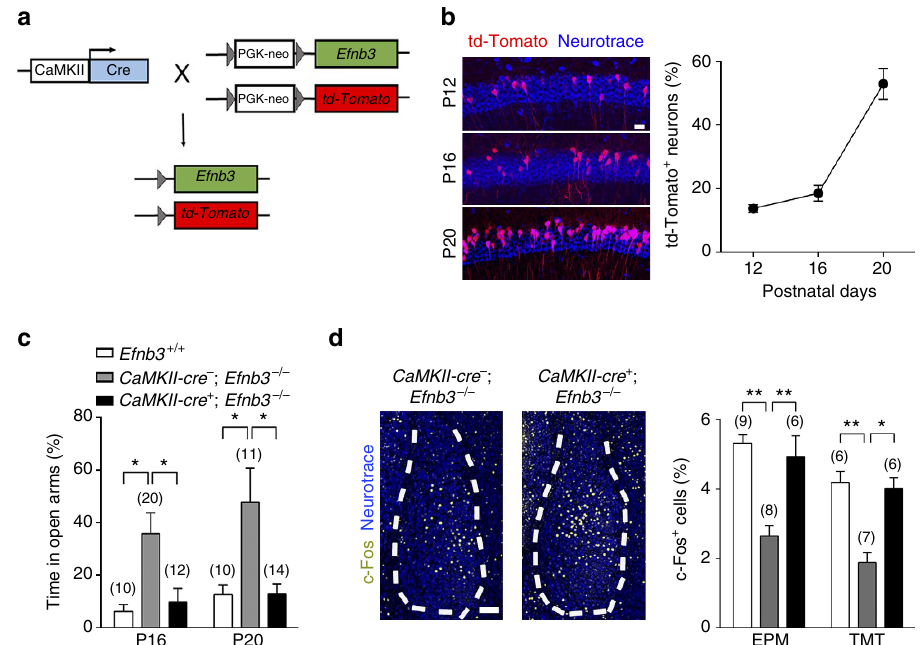
Figure 3 | Spatial-specific rescue of eB3 restores defensive responses in Efnb3 (cid:2) / (cid:2) mutant. ( a ) Transgenic mice expressing CaMKII-Cre recombinase were crossed with td-Tomato þ ; Efnb3 (cid:2) / (cid:2) homozygotes. EB3 expression in the initial td-Tomato þ ; Efnb3 (cid:2) / (cid:2) mutant was restored and indicated with td-Tomato reporter on Cre -mediated excision of the loxP -flanked PGK neo cassette. ( b ) CaMKII-cre mediated recombination in CA1 area visualized with td-Tomato fluorescence was detected in P12, P16 and P20 hippocampal sections in CaMKII-cre þ ; td-Tomato þ ; Efnb3 (cid:2) / (cid:2) mice. Scale bar, 50 m m. The percentage of td-Tomato-positive cells in CA1 area increased gradually during postnatal development. n ¼ 3 mice for per group. ( c ) CaMKII - cre þ ; Efnb3 (cid:2) / (cid:2) mice showed a shorter time than CaMKII - cre (cid:2) ; Efnb3 (cid:2) / (cid:2) mice in open arms of EPM at P16. The experiments were triplicated independently. n values of mice used are indicated above group bars. * P o 0.05, one-way ANOVA. ( d ) Representative images showing the c-Fos-positive cells in amygdala of CaMKII - cre (cid:2) ; Efnb3 (cid:2) / (cid:2) and CaMKII - cre þ ; Efnb3 (cid:2) / (cid:2) mice at P16. Scale bars, 100 m m. The percentage of c-Fos-positive cells in BLA of CaMKII - cre þ ; Efnb3 (cid:2) / (cid:2) mice was restored compared with that of CaMKII - cre (cid:2) ; Efnb3 (cid:2) / (cid:2) following an EPM or TMT behaviour trial at P16. n values of mice used are indicated above group bars. * P o 0.05; ** P o 0.01; *** P o 0.001, one-way